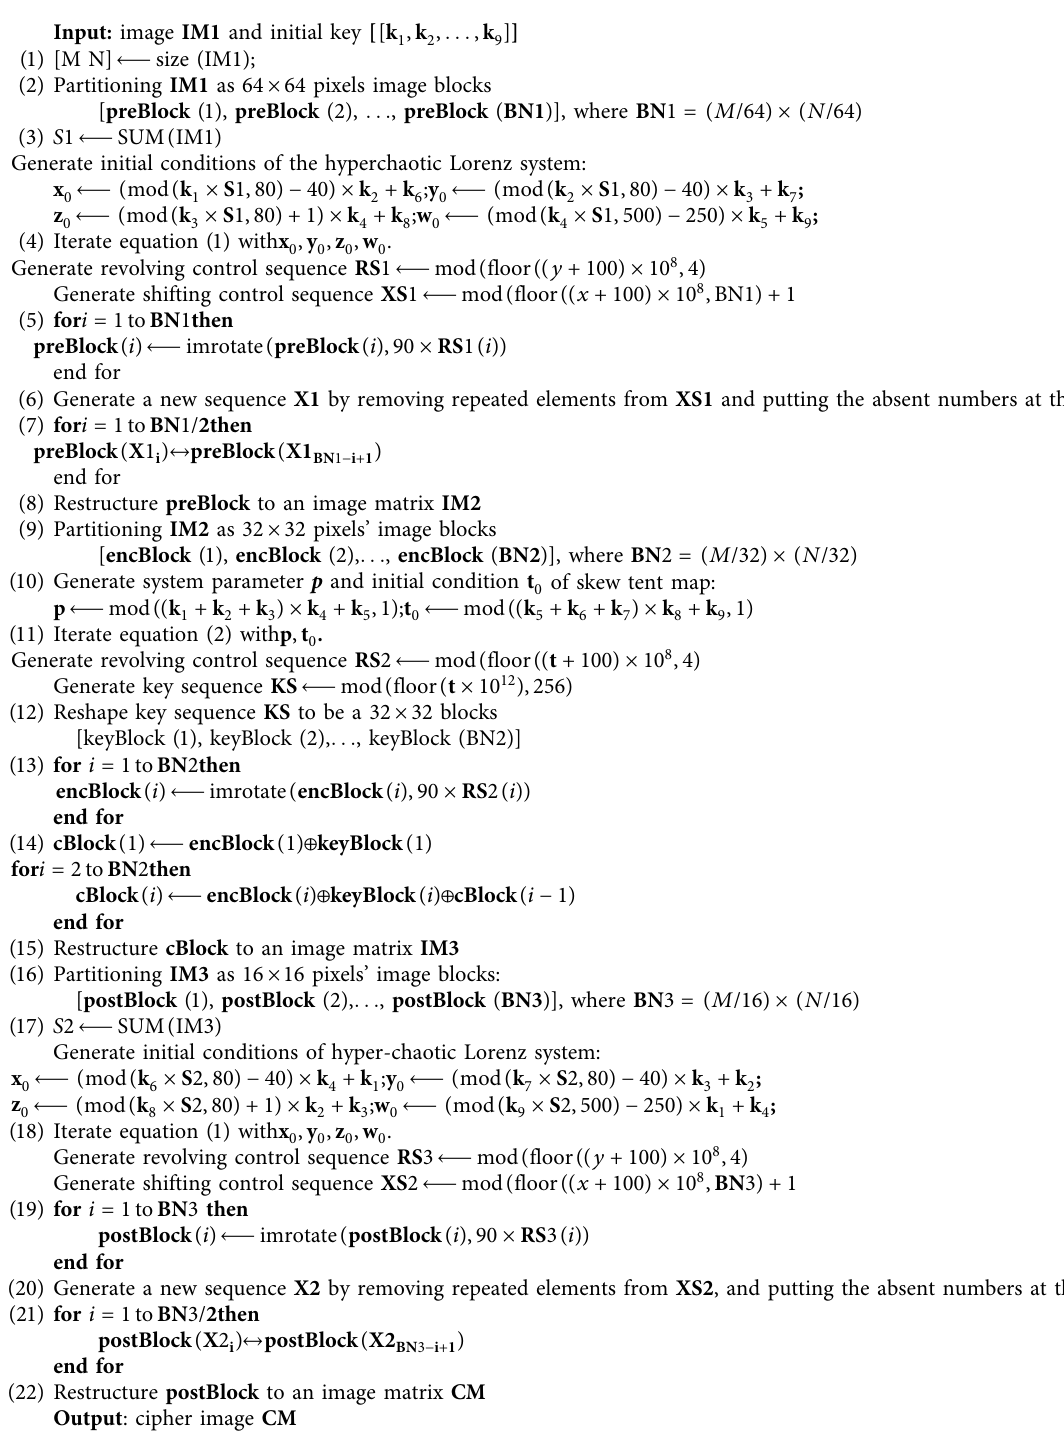
A LGORITHM 1: Encryption